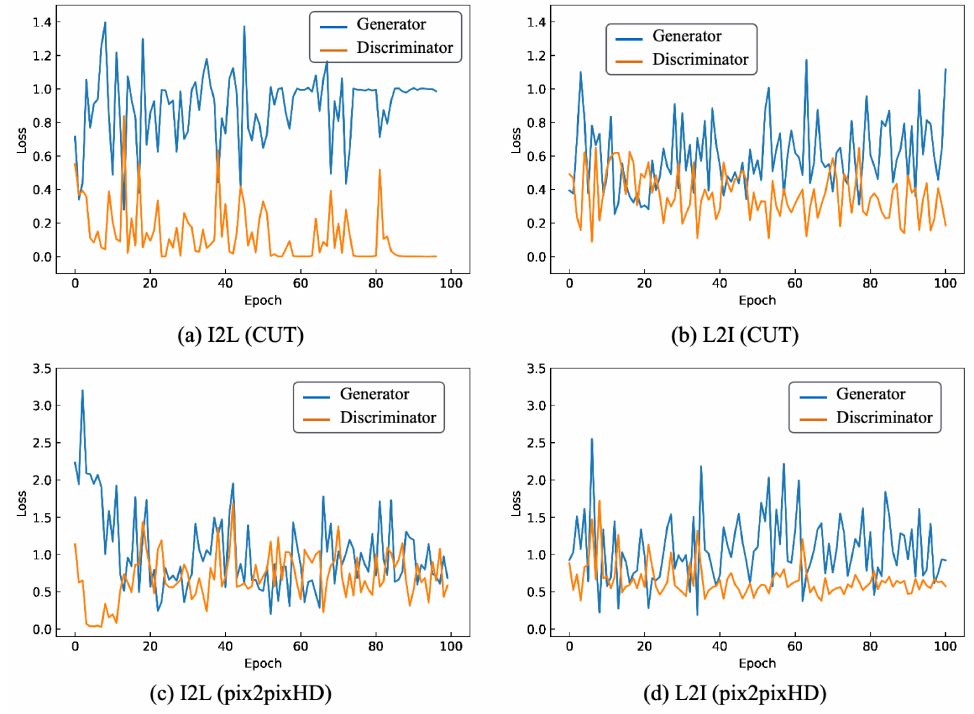
Figure 12. Time-series training loss trends for the respective GANs in Soybeans.